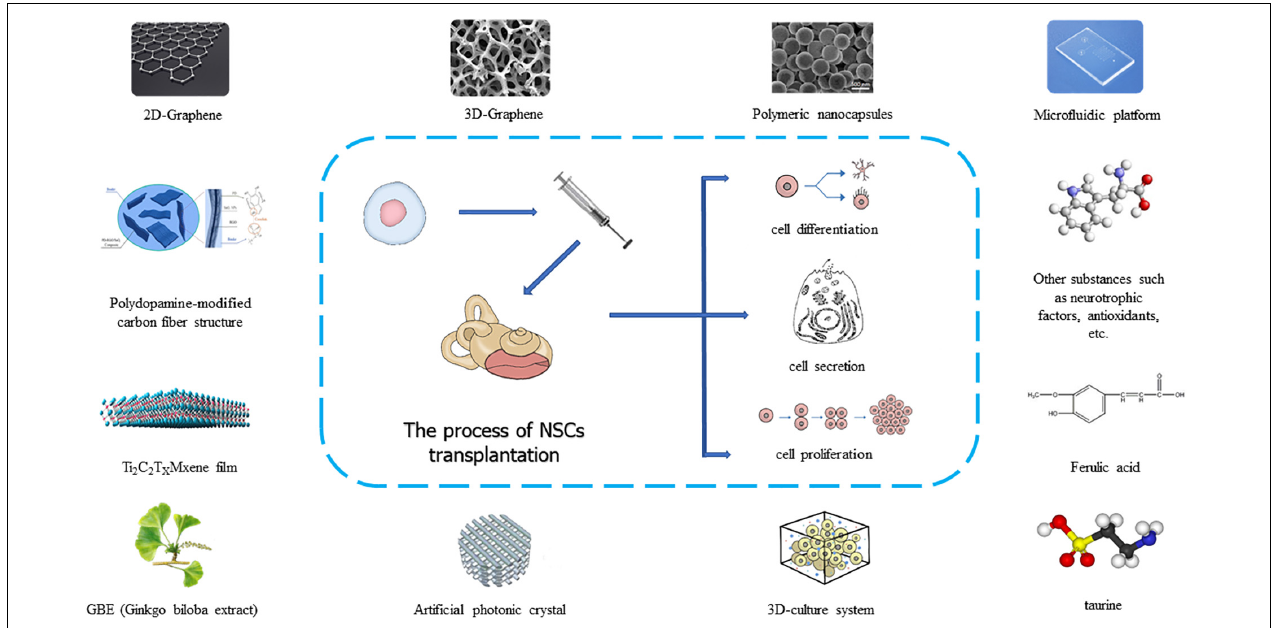
FIGURE 2 | Application of new materials and new substrates in neural stem cell